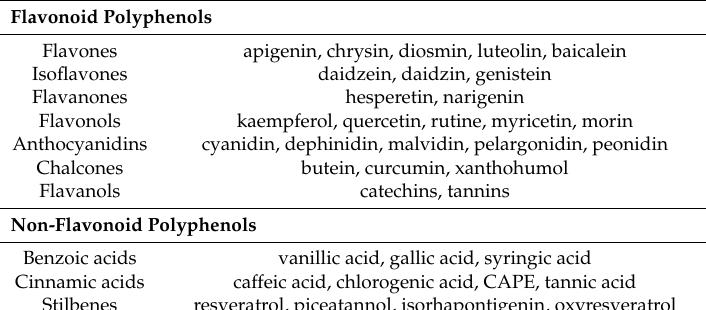
Table 1. Polyphenols classes and examples of more relevant compounds.